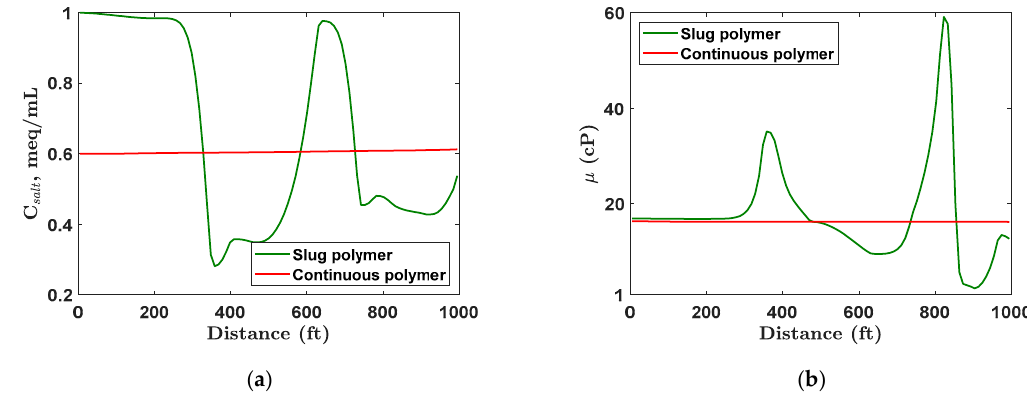
Figure 6. Water salinity ( a ), and aqueous phase viscosity ( b ) profiles versus distance for the slug-based (green) and continuous (red) polymer schemes in layer eight (middle) at t D =